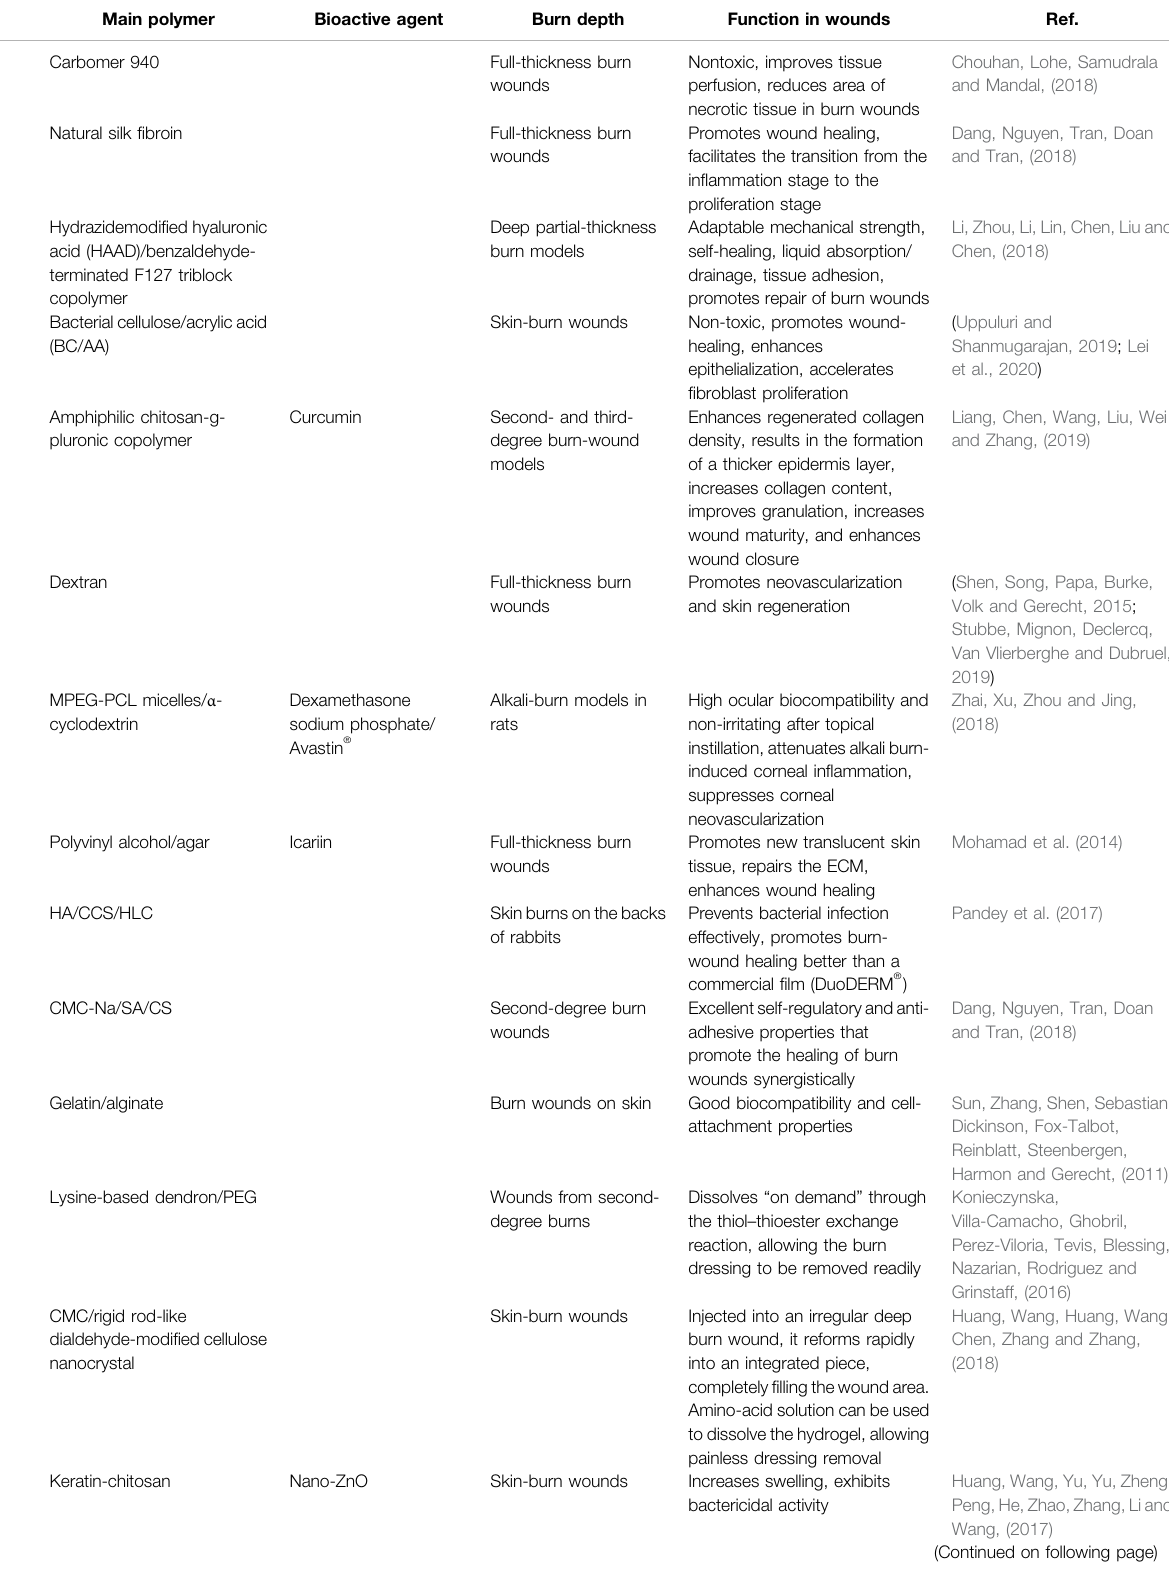
TABLE 1 | Summary of commonly employed polymers in hydrogel dressings and their functions in wound management.